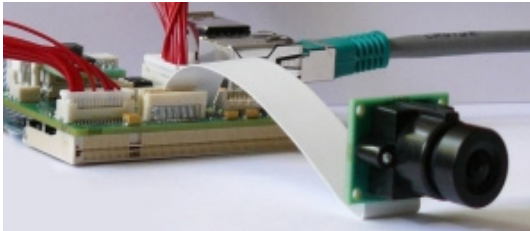
Figure 7. Camera and image processing board components comprising sun tracking sensor.